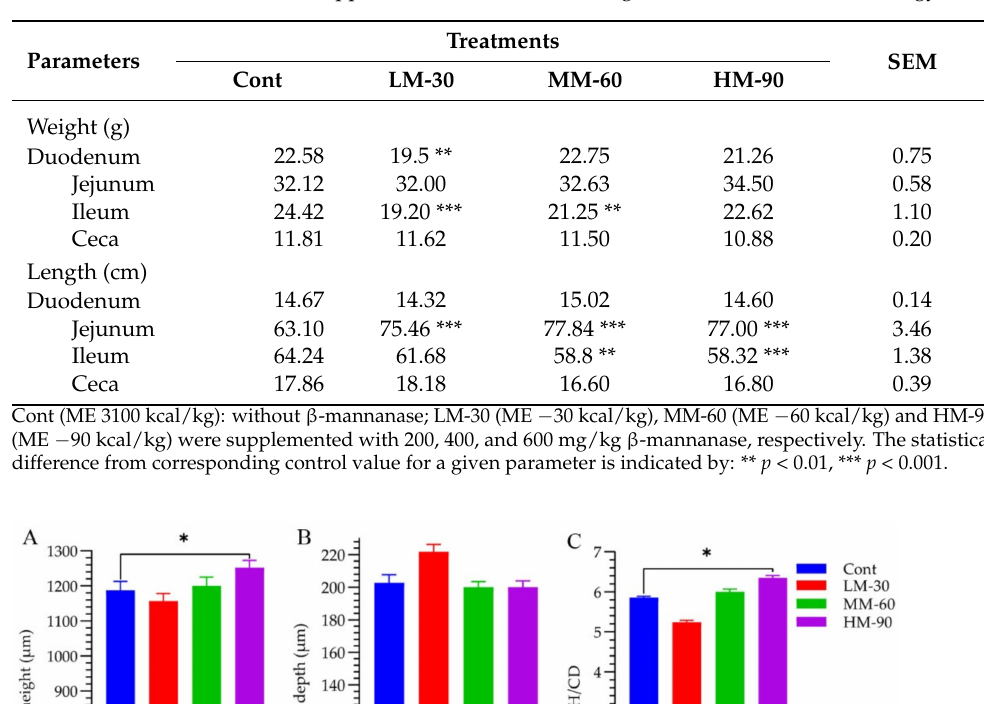
Table 5. Effect of β -mannanase supplementation on intestinal segments in broilers fed low energy diets.